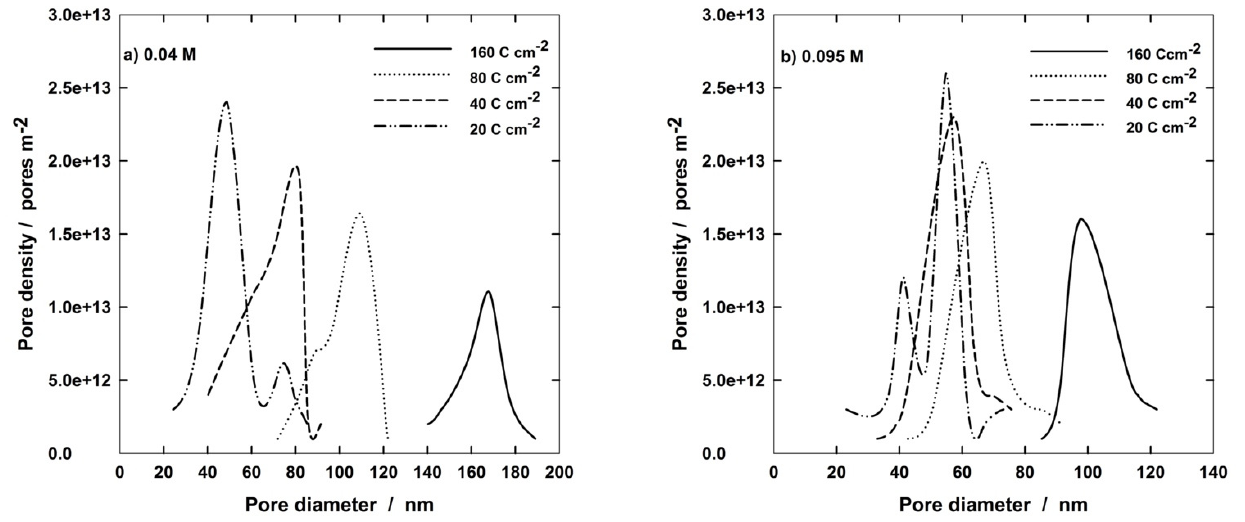
Figure 10. Diameter distribution of PAA formed at 160 V and 272.15 °K in ( a ) 0.4 H 3 PO 4 and 0.04 Al(OH) 3 ; ( b ) 0.4 M H 3 PO 4 and 0.09 5 M Al(OH) 3 .